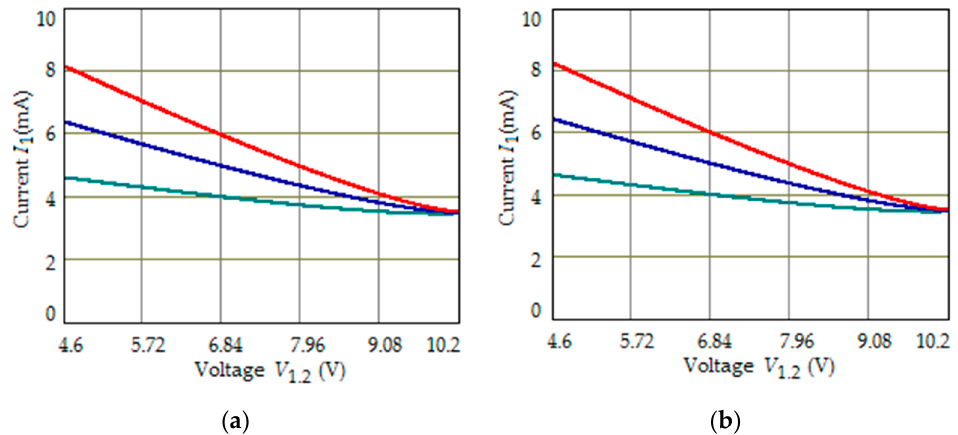
Figure 15. ( a ) Calculated current-voltage characteristics of the NDR circuit with multiple-output cascode current mirror in the NDR region; m = 0—green curve, m = 1—blue curve, m = 2—red curve. ( b ) Calculated current-voltage characteristics of the NDR circuit with multiple-output Wilson current mirror in the NDR region; m = 0—green curve, m = 1—blue curve, m = 2—red curve.